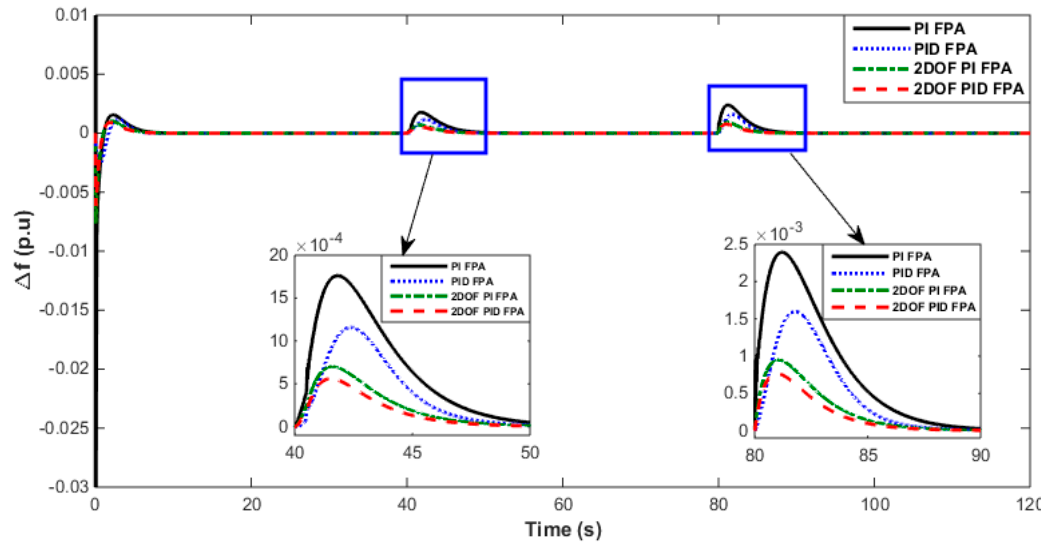
Figure 5. Comparative changes in the frequency deviations observed with the FPA-tuned proportional-integral (PI), PI with derivative (PID), two-degree-of-freedom (2DOF) PI, and 2DOF PID controllers in case 1.